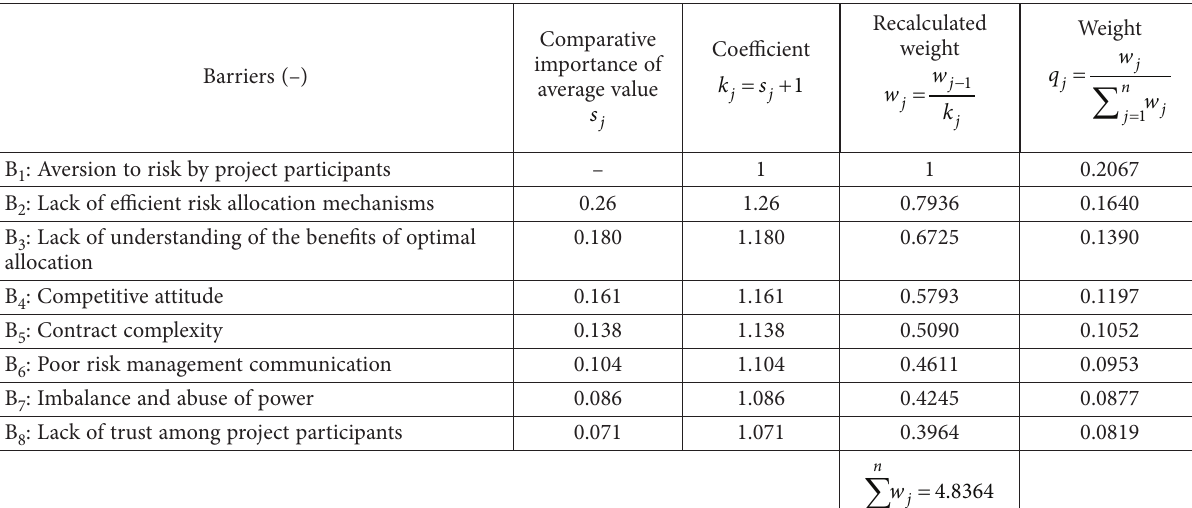
Table 7. The weight of risk allocation